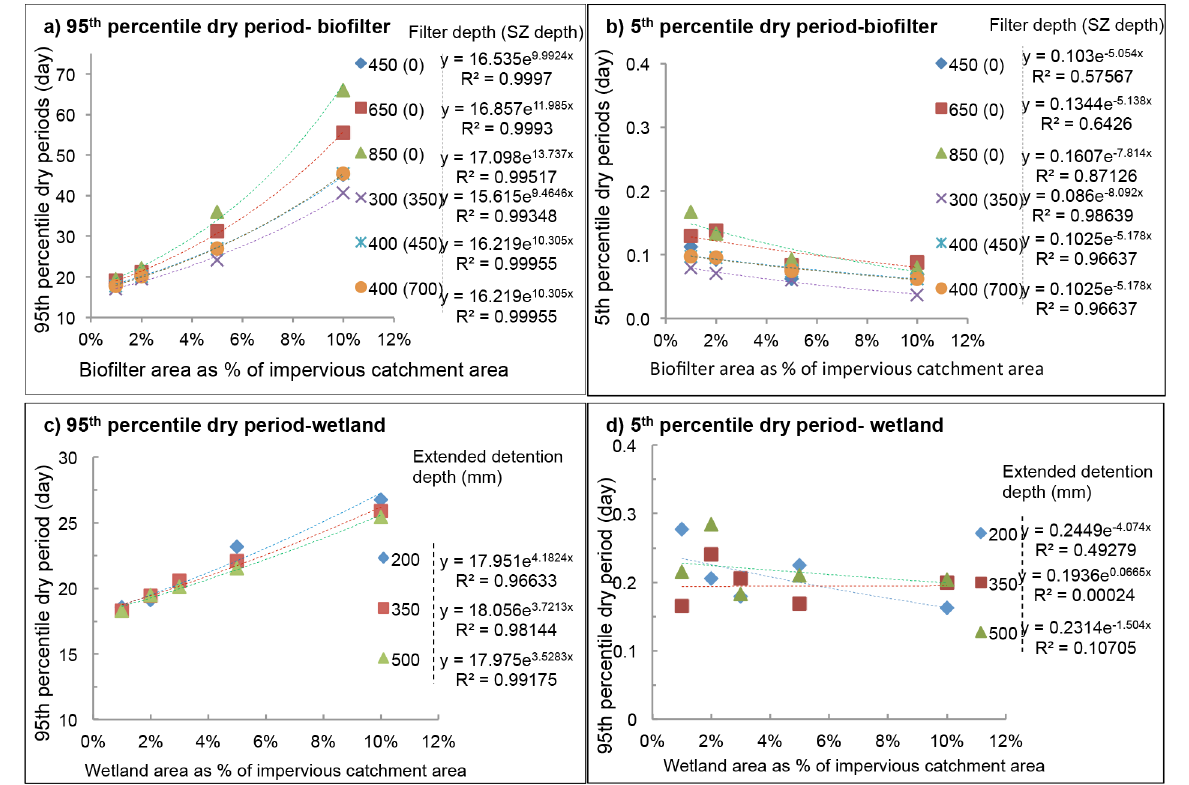
Fig 2. Plots of LDPs as a function of system area as percent of impervious catchment for mild oceanic climate (Melbourne): a) 95 th percentile and b) 5 th percentile dry period for biofilters at the designed hydraulic conductivity 100 mm/h and extended detention depth 200 mm. c) 95 th percentile and d) 5 th percentile dry periods for wetlands at permanent pool depth of 250mm. SZ : submerged zone .